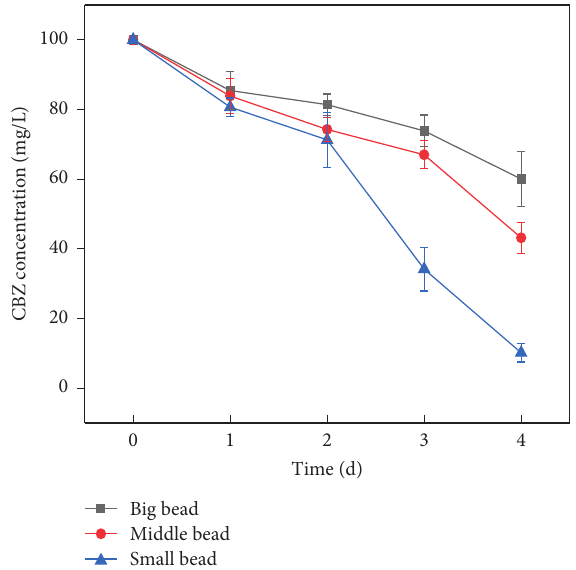
Figure 4: The effect of bead size of ANFICV on CBZ